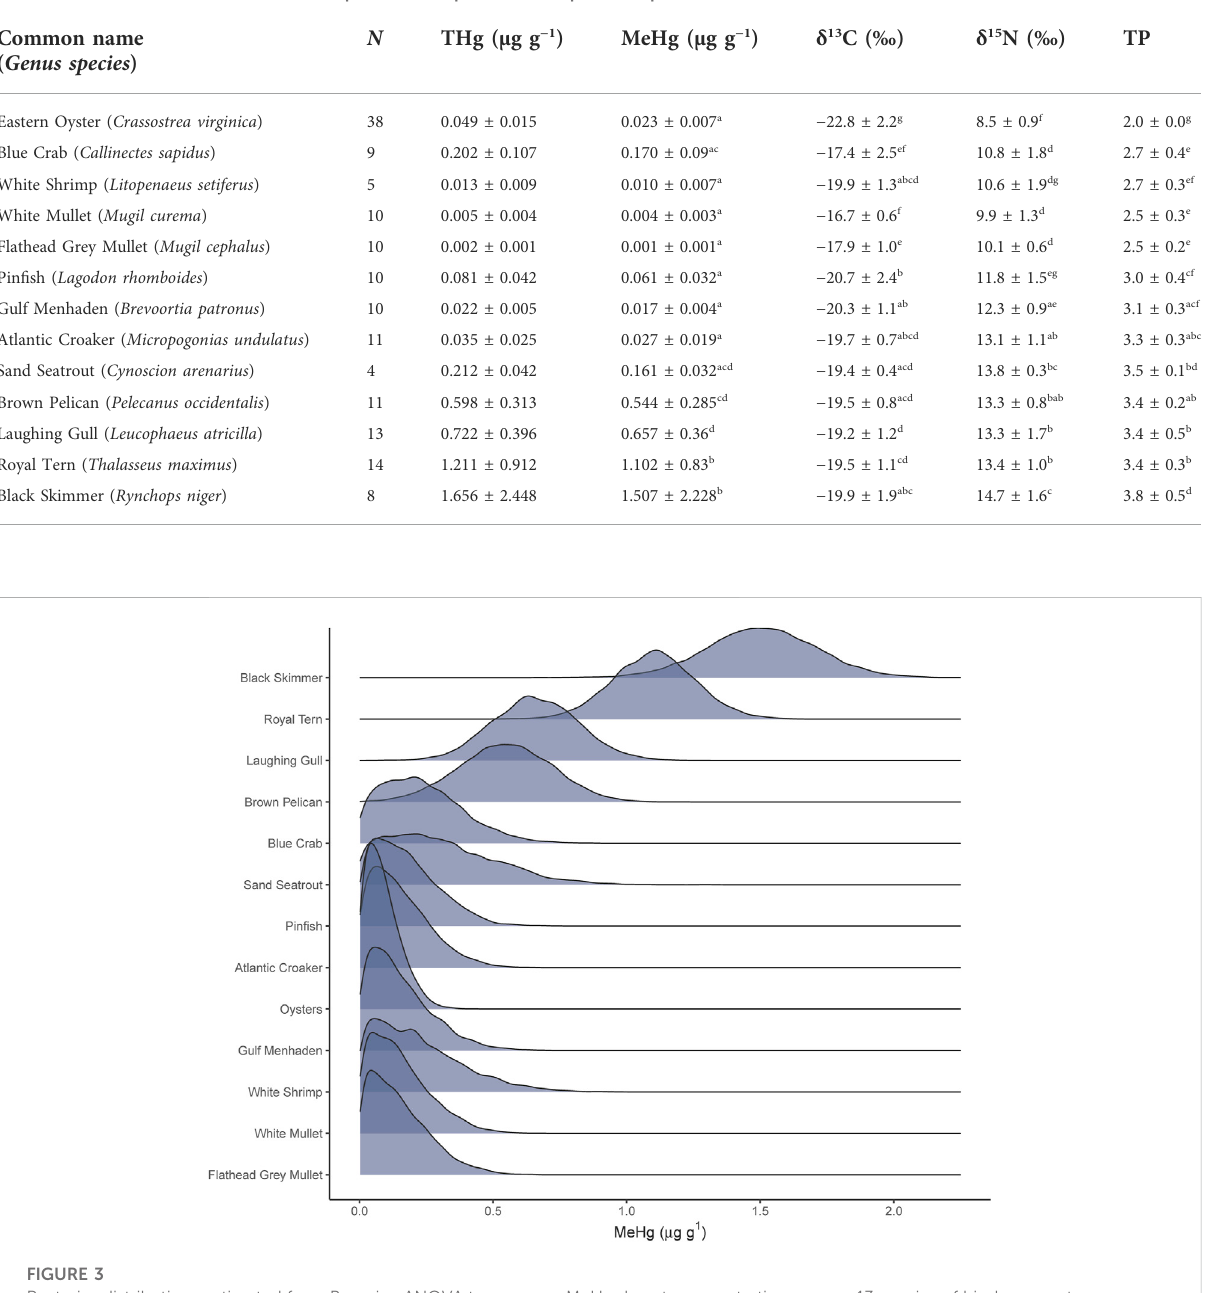
TABLE 3 Stable isotope values and Hg concentrations measured in tissues of consumers collected in coastal Louisiana following 2010 Deepwater Horizon oil spill. Trophic position (TP) estimates were estimated using δ 15 N of bivalves as the isotopic baseline to compare subsequent consumers. MeHg concentrations were estimated using literature values averaged across groups of seabirds, fi shes, and species-speci fi c invertebrates (Table 1). The total number (N) of individuals sampled is reported for each species along with mean ±1 standard deviation for each variable. Results of post hoc comparisons of each variable across species are represented by lettered superscripts. Species that do not share the same letter within the same column have pairwise comparisons with posterior probabilities ≥ 95%.